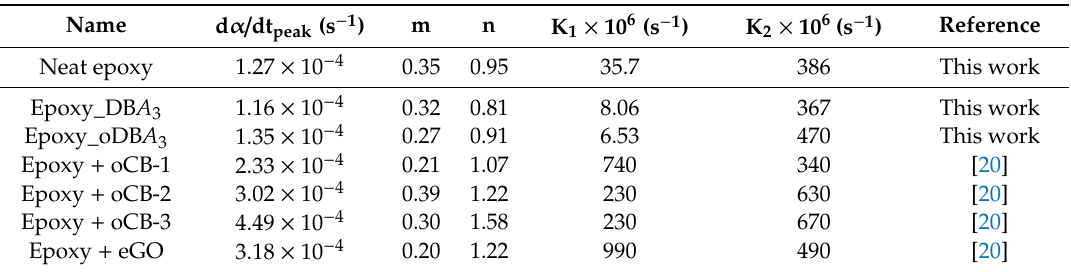
Table 6. The d α / dt peak and kinetic model parameters, according to Equation (2), compared to that obtained in the presence of di ff erent oxidized carbon blacks (oCB-1, oCB-2, oCB-3) and graphene oxide (eGO) with the same resin composition [20]